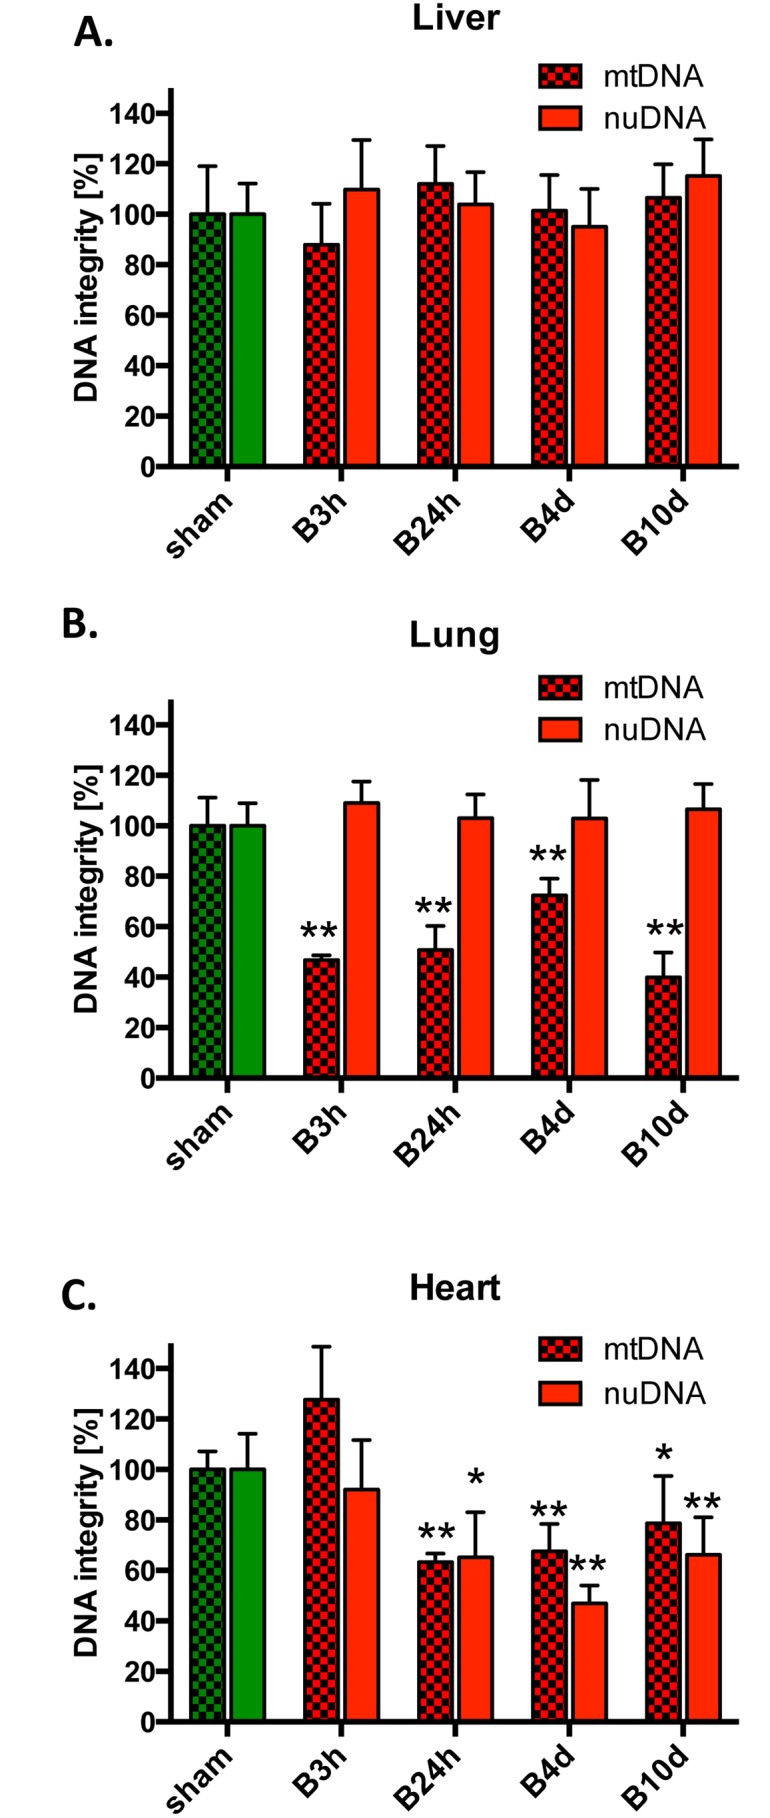
Changes in mitochondrial and nuclear DNA integrity in response to burn injury.Damage to nuclear and mitochondrial DNA was quantified using LA-PCR assay in (A) liver, (B) lungs and (C) heart of mice subjected to burn injury. The results are based on n = 6 per group and represent mean±SD. *, ** p<0.05 and p<0.01 respectively, relatively to sham animals.